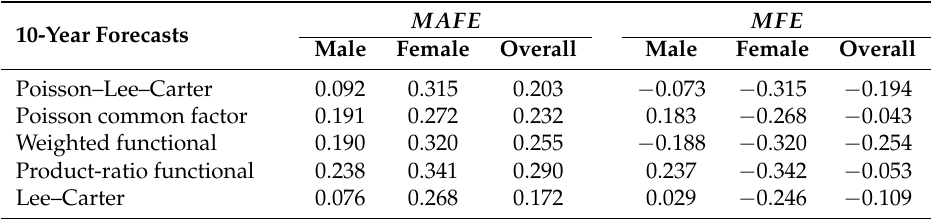
Table 8. Mean Absolute Forecast Error ( MAFE ) and Mean Forecast Error ( MFE ) of life expectancy at birth for males and females by method for